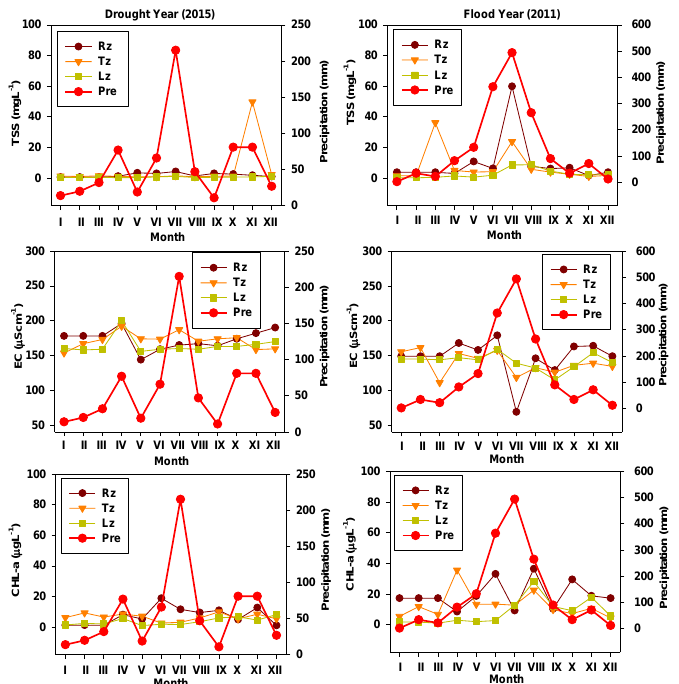
Figure 4. Monthly variation of drought year (2015) and flood year (2011) of TSS, EC, and CHL-a in Rz, Tz, and Lz zones (Rz: riverine zone, Tz: transitional zone, Lz: lacustrine zone, TSS: total suspended solids, EC: electrical conductivity, CHL-a: chlorophyll-a, and I–XII: January–December).